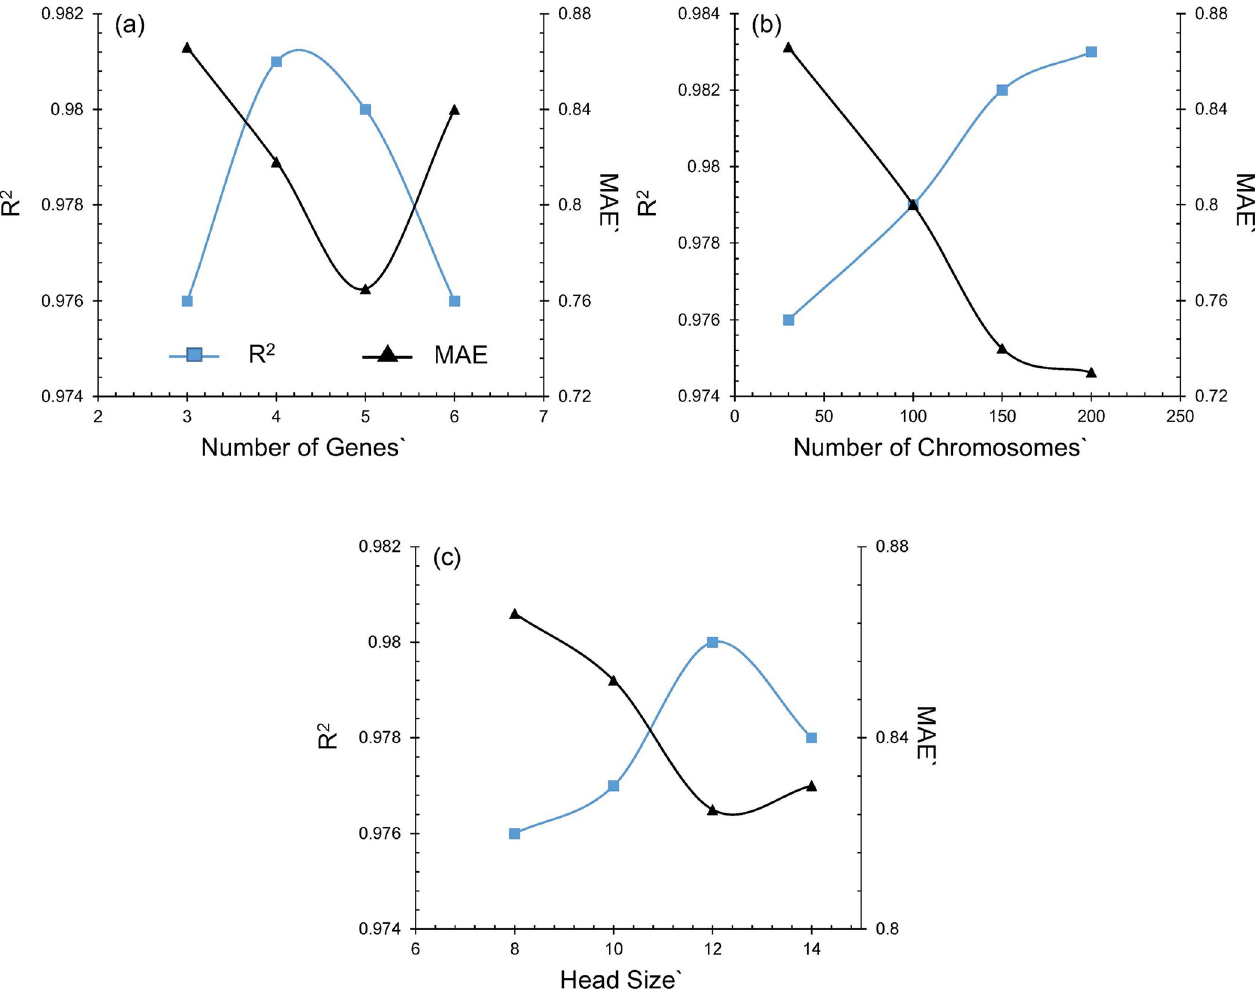
Fig 6. Effect of parametric variation of GEP algorithm on accuracy of predicted plastic liquid: (a) number of genes; (b) number of chromosomes (c) head size.